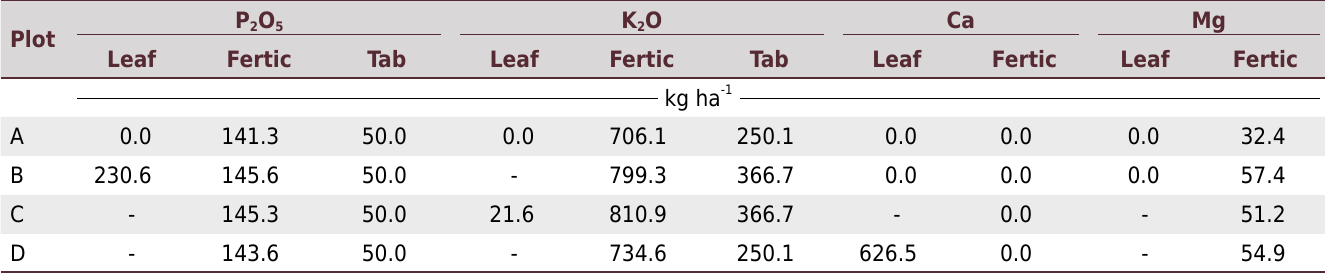
Table 9. Comparison of the recommended rates of phosphorus (P 2 O 5 ), potassium (K 2 O), calcium (Ca), and magnesium (Mg) through leaf analysis, FERTICALC ® -Bananeira, and Recommendation Table